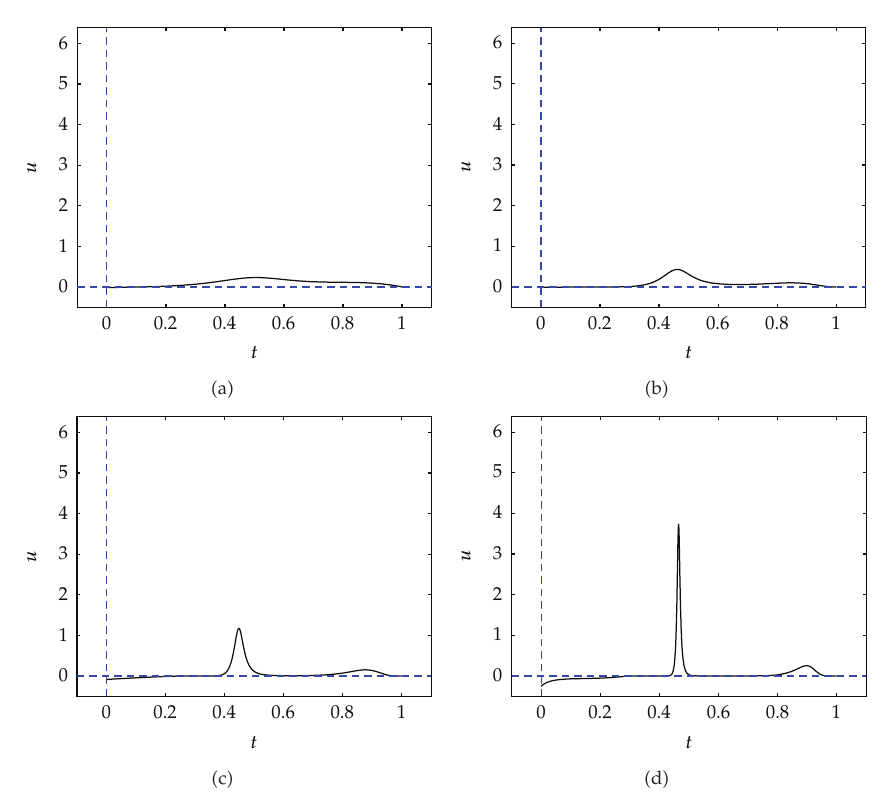
Figure 7: Evolution of the control field u for di ff erent values of the homotopy parameter λ , which is equal to 0, 0.6, 0.8, 0.9 from (cid:3) a (cid:4) to (cid:3) d (cid:4) . The transfer time normalized to 1 is equal to 2 T min